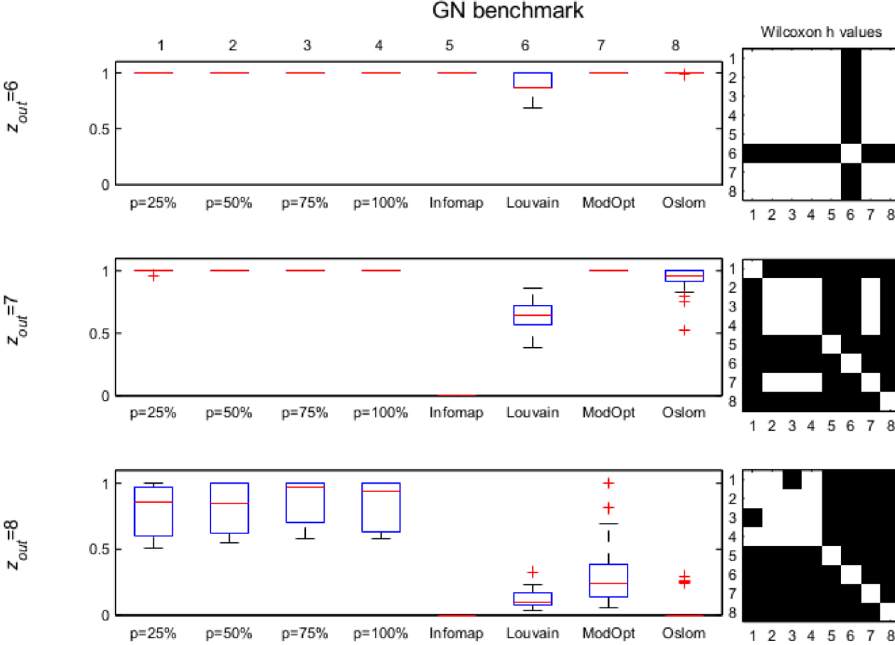
Fig 6. GN z out = 6, 7, 8; boxplots of NMI values for all methods considered (left). On the right, the black- white matrix represents Wilcoxon h values for each pair of methods considered, numberedin the order they appearin the boxplot. A black square indicatesa statistical difference betweenresults. For z out = 8 results obtained with all values of p are significantly better than all other methods considered.